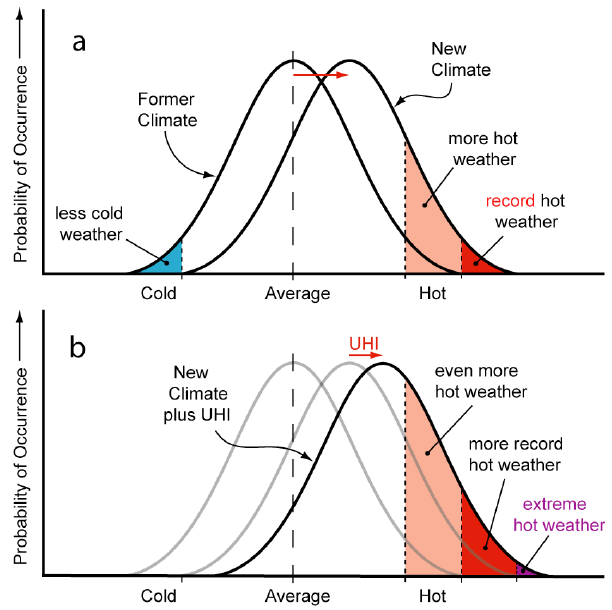
Figure 3. The Combined Impact of Climate Change ( a ) and the Urban Heat Island (UHI) Effect ( b ).